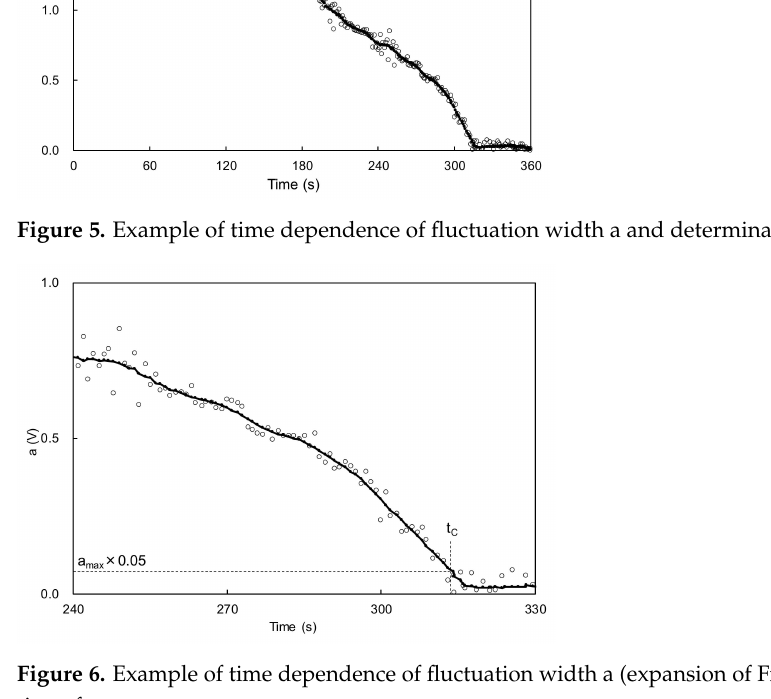
Figure 6. Example of time dependence of fluctuation width a (expansion of Figure 5) and determina- tion of t C